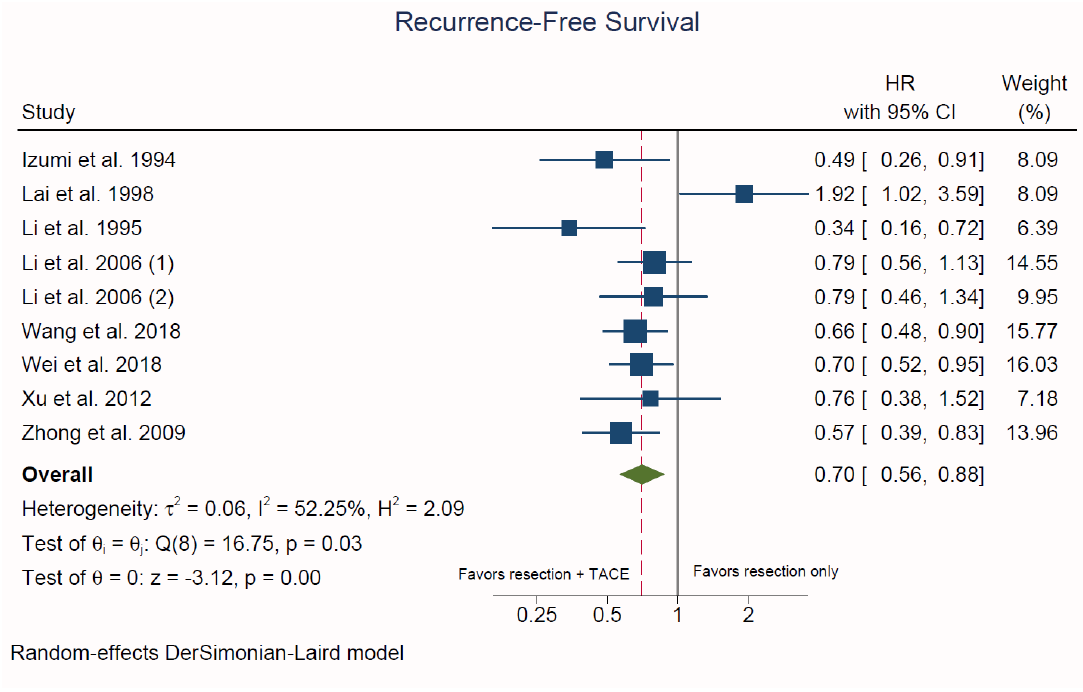
Figure 4. Forest plot of recurrence-free survival. HR: hazard ratio; CI: confidence interval.